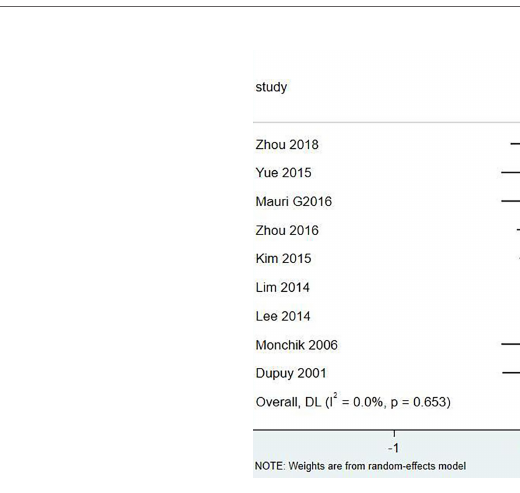
FIGURE 7 | Major complication rate of thermal ablation located in the central